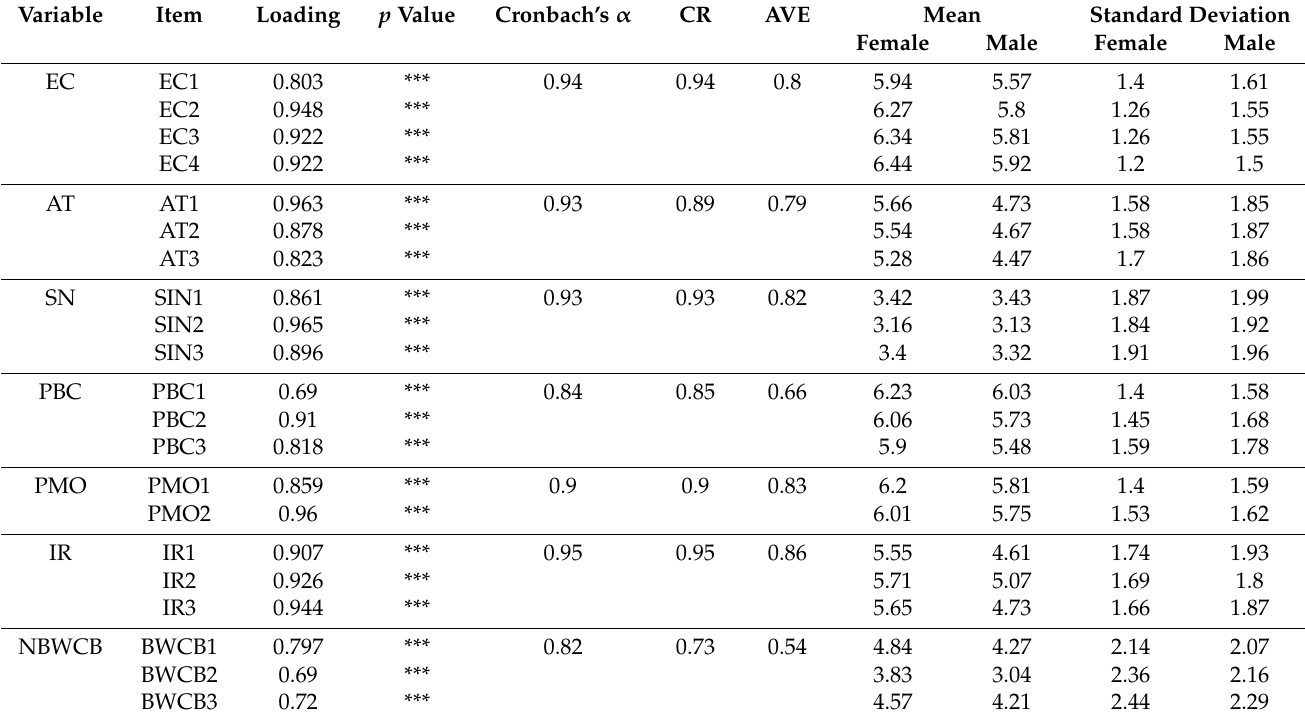
Table 2. Constructs, reliability, and convergent validity.